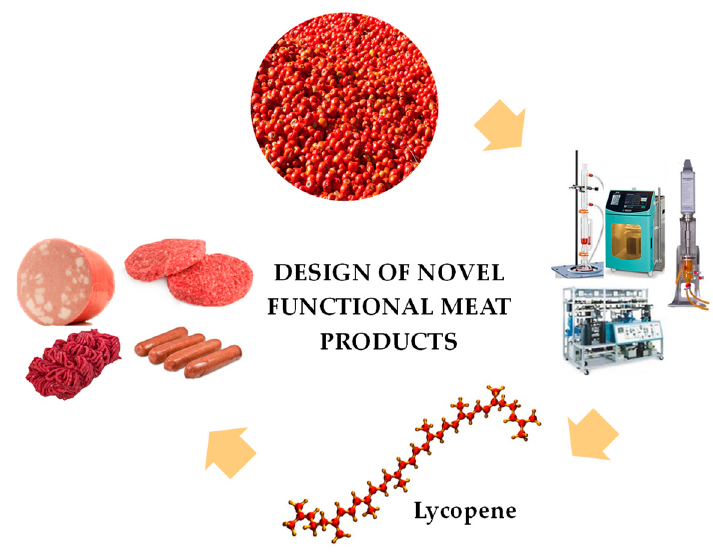
Figure 1. Overview of lycopene extraction technologies from tomato by-products and their application in meat products.